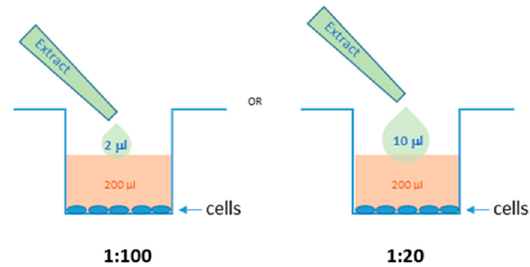
Figure 9. Ethanolic E. ciliata extracts dilution with cell medium for anti-inflammatory activity experiments.